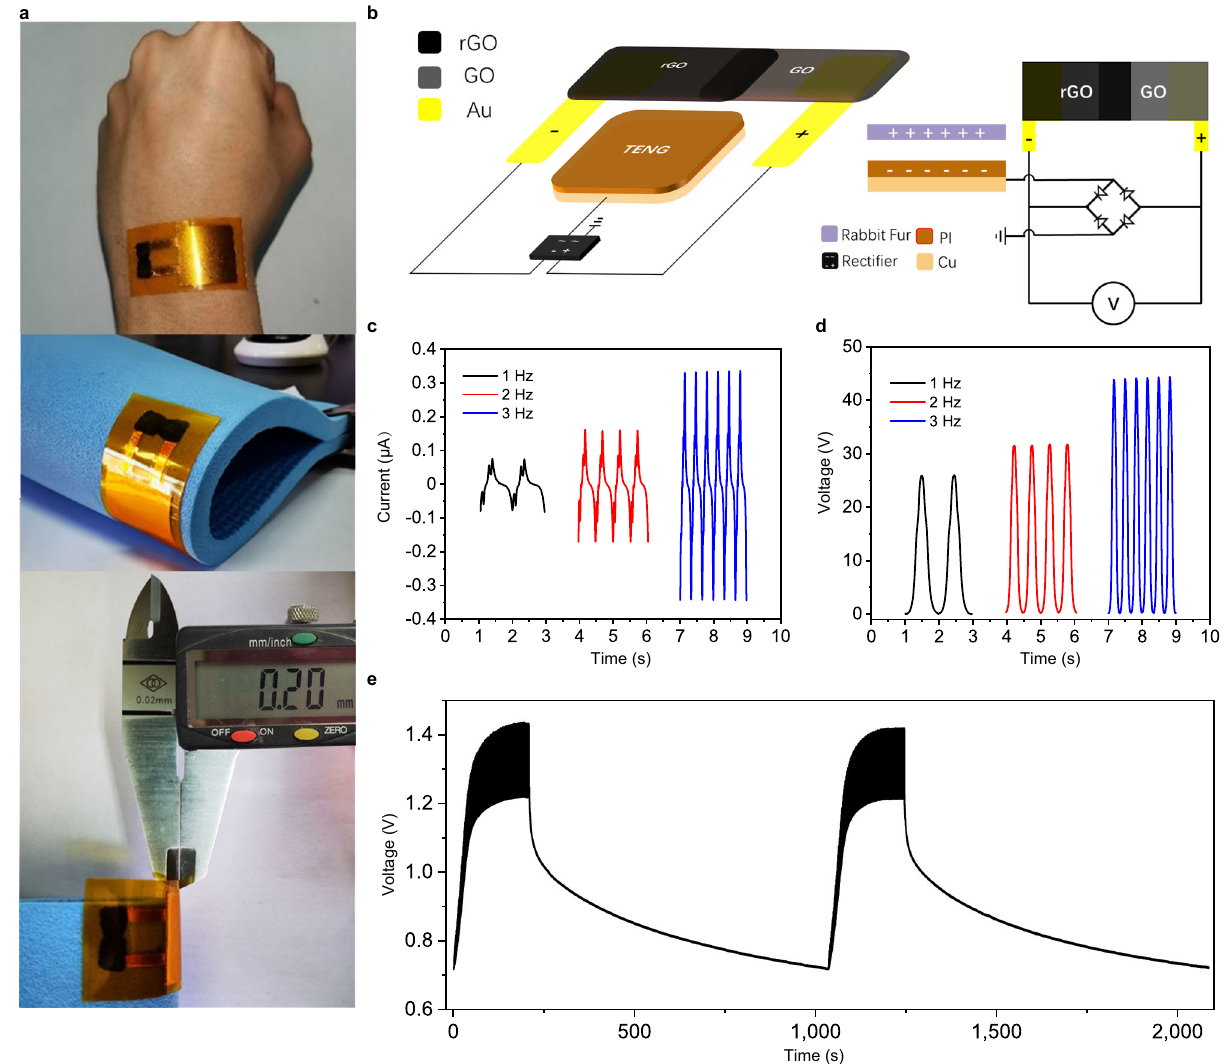
Fig. 2 | Design and characterization of the triboiontronic device. a The inte- grated energy harvesting (TENG) and storage (osmotic power source) triboion- tronic device is bendable and its thickness is around 200 μ m. b Structure of the integrateddevice. c Currentand d VoltagegeneratedbytheTENG. e Voltagepro fi le